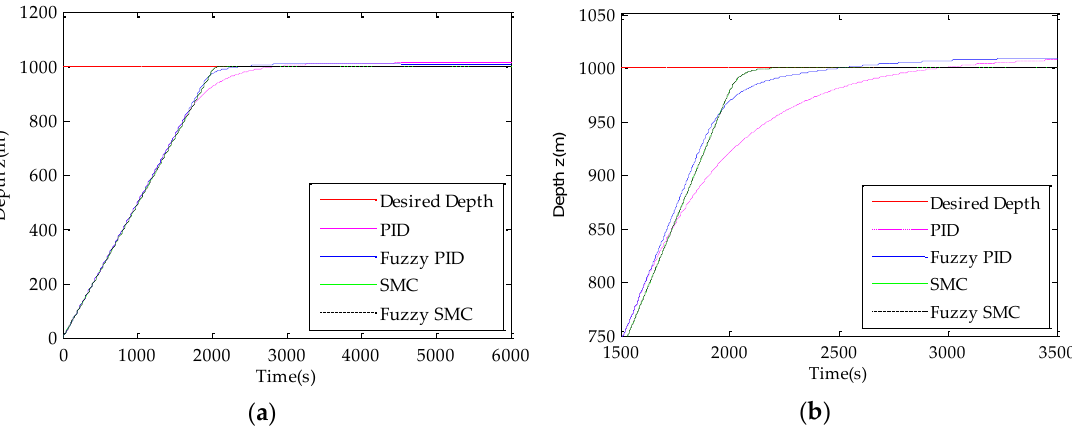
Figure 11. Control response curves without disturbing force. ( a ) Depth response curves. ( b ) Magnified view of depth response curves.